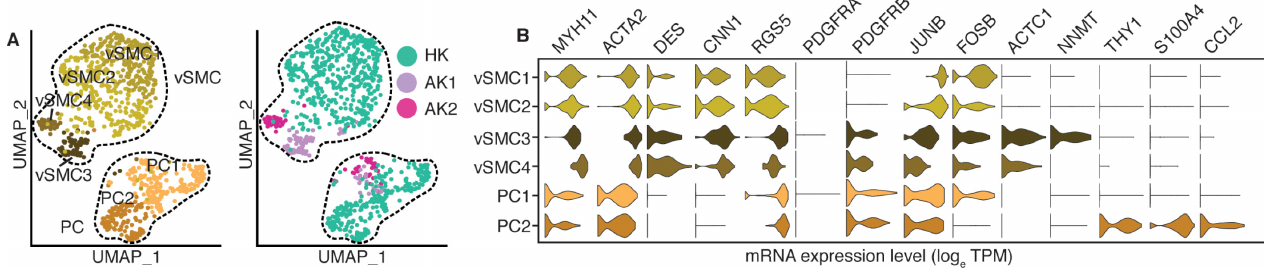
Fig 7. Sub-clustering of pericytes and vascular smooth cells. (A). UMAP-based visualization of subpopulations of pericytes and vascular smooth muscle cells. In the left panels the pericytes and vascular smooth muscle cells are colored by different sub-populations. In the right panel the cells are colored by the biopsies HK, AK1 and AK2. (B). Violin plots of the expression of lineage gene markers of pericytes and vascular smooth muscle